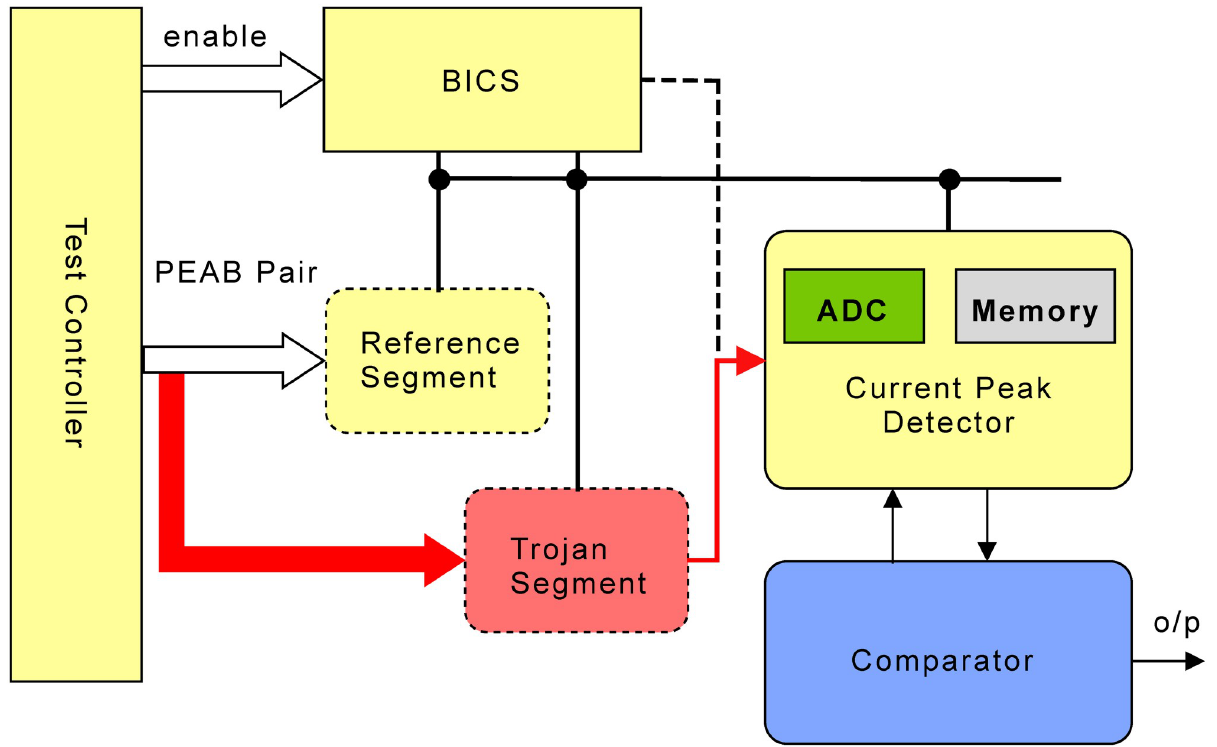
Fig 7. Self-referencing with built-in current sensors and memory